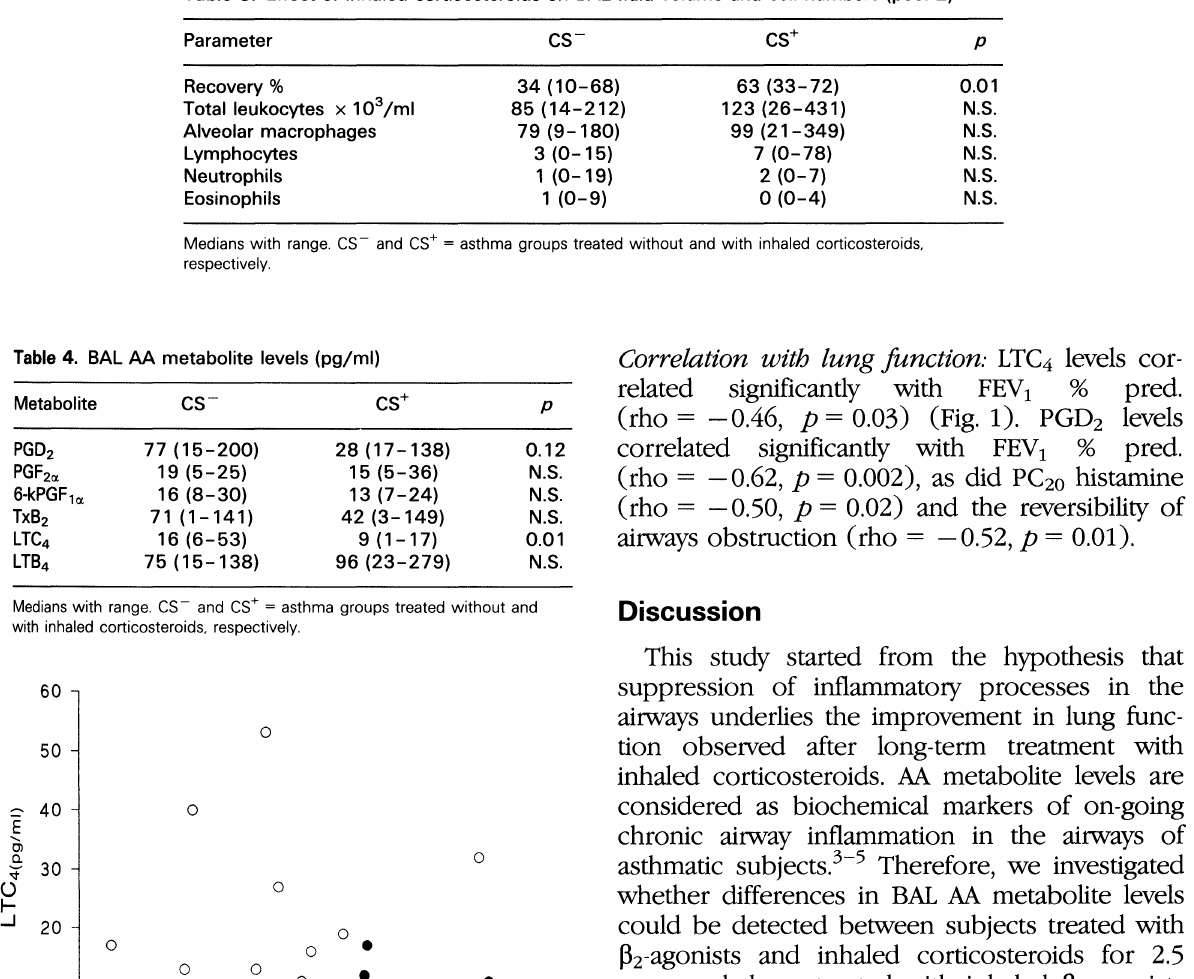
Medians with range. CS- and CS asthma groups treated without and with inhaled corticosteroids, respectively.